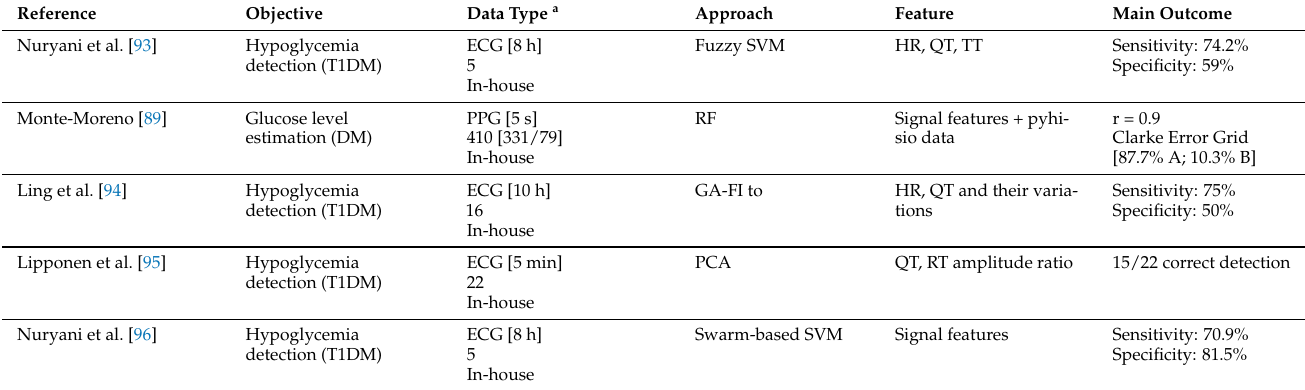
Table 6. Machine learning methods for blood glucose estimation and